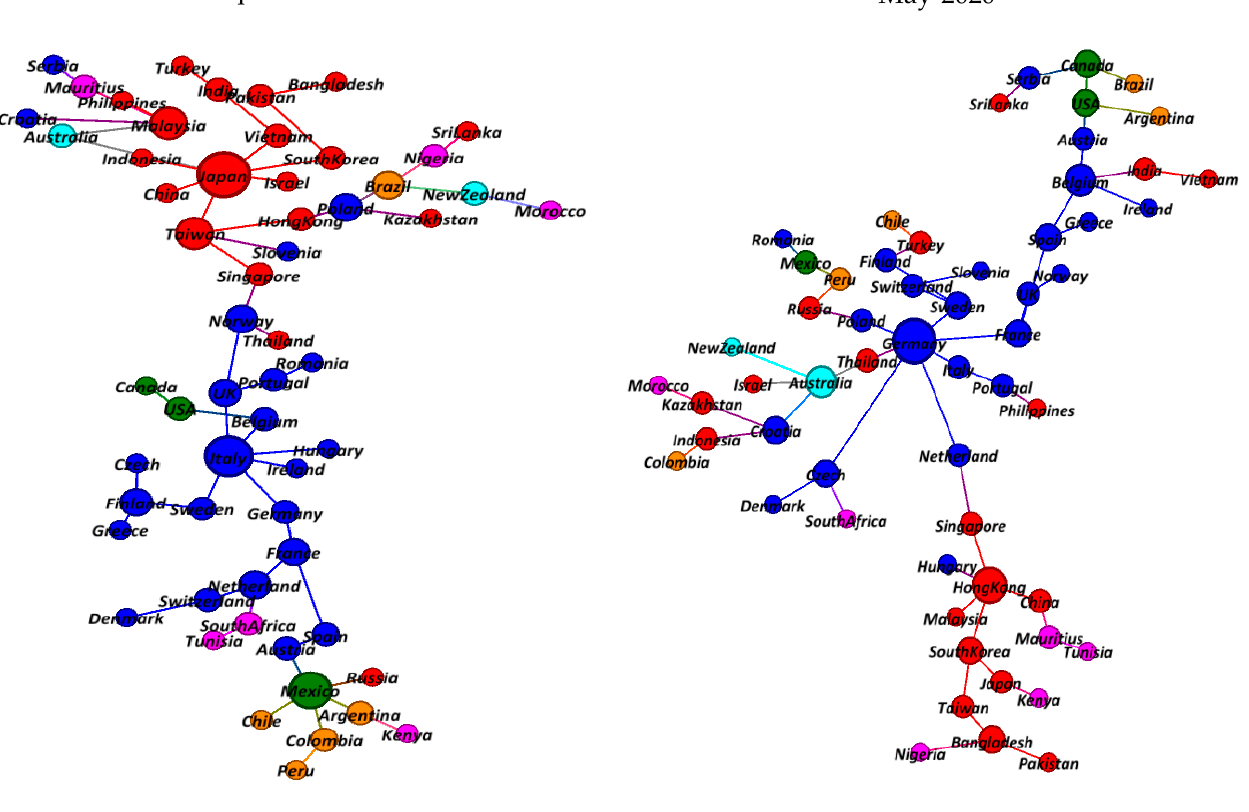
Figure 3. Comparison of dynamic MSTs of the world stock market network from April 2020 to July 2020.